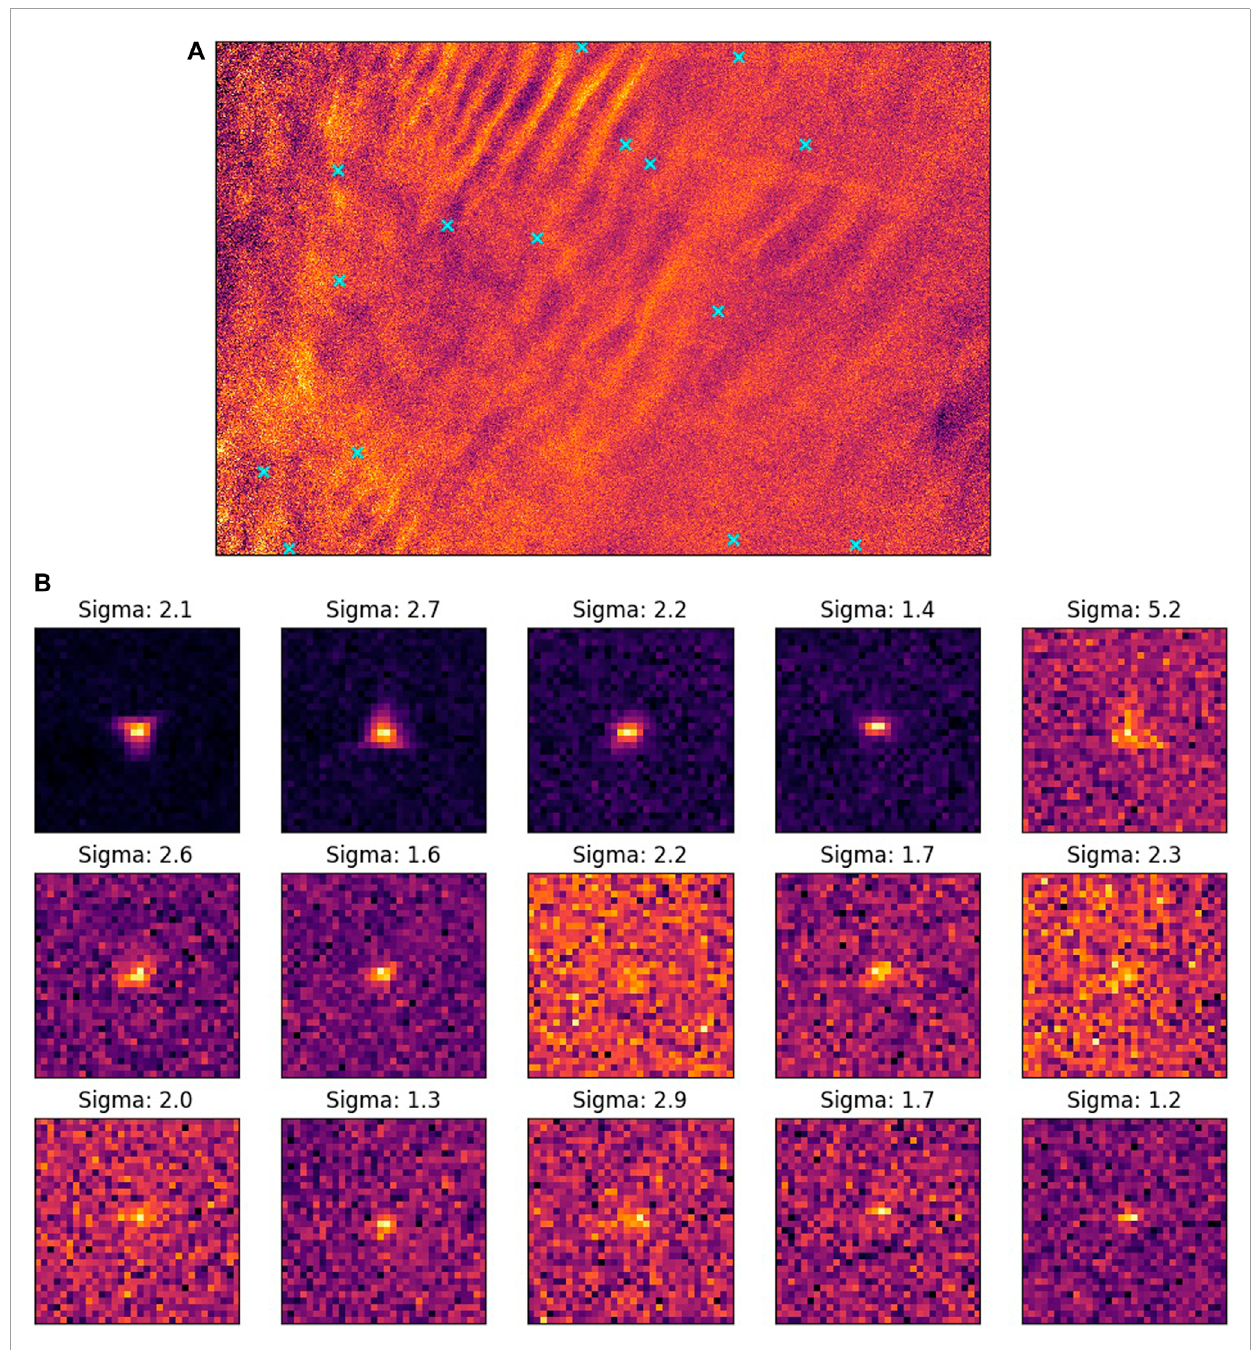
FIGURE 4 An example of star identification. Figure originally published in Kjellstrand (2021). (A) Cyan X’s mark the location of stars found with the SkyWinder star identification algorithm. The image shown has been calibrated and stray light have been removed, but not projected. (B) Close up view of fifteen of the stars identified in (A)